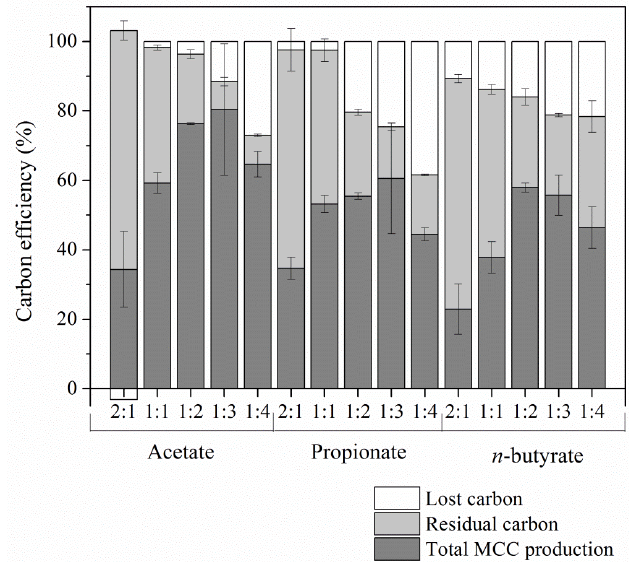
Figure 8. Lost carbon efficiency, residual carbon efficiency, and total MCC production efficiency at